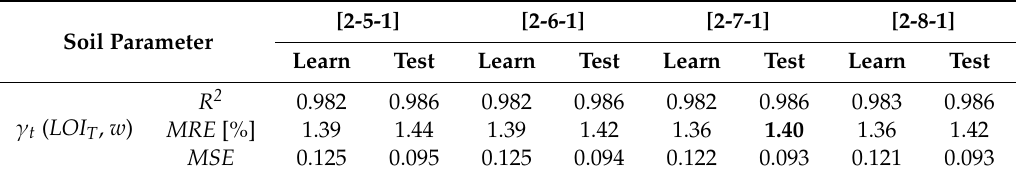
Table 6. The goodness of fit of the ANN models with two inputs.